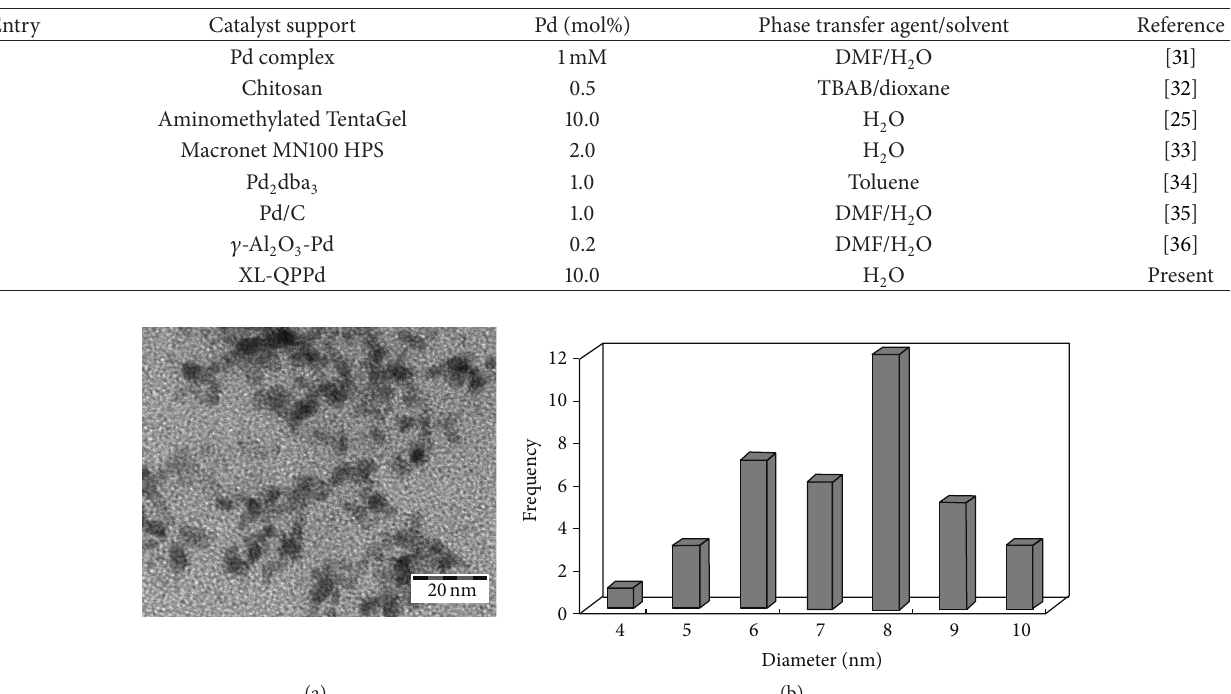
Figure 4: Transmission electron microscopy (TEM) observed physically captured and entrapped on the QuadraPure resin (a) and size distribution of Pd 0 nanoparticles (b).